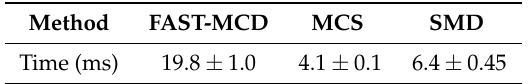
Figure 10. Comparison of ( a ) FAST-MCD, ( b ) MCS, and ( c ) SMD methods of core points determination (core points marked with green) for exemplary, roughly planar points cluster (blue points) containing a fragment of other planar group (orange points). Fitted plane is depicted in dark gray. Table 6. Time comparison for FAST-MCD, MCS and the proposed SMD method for core points selection for points presented in Figure